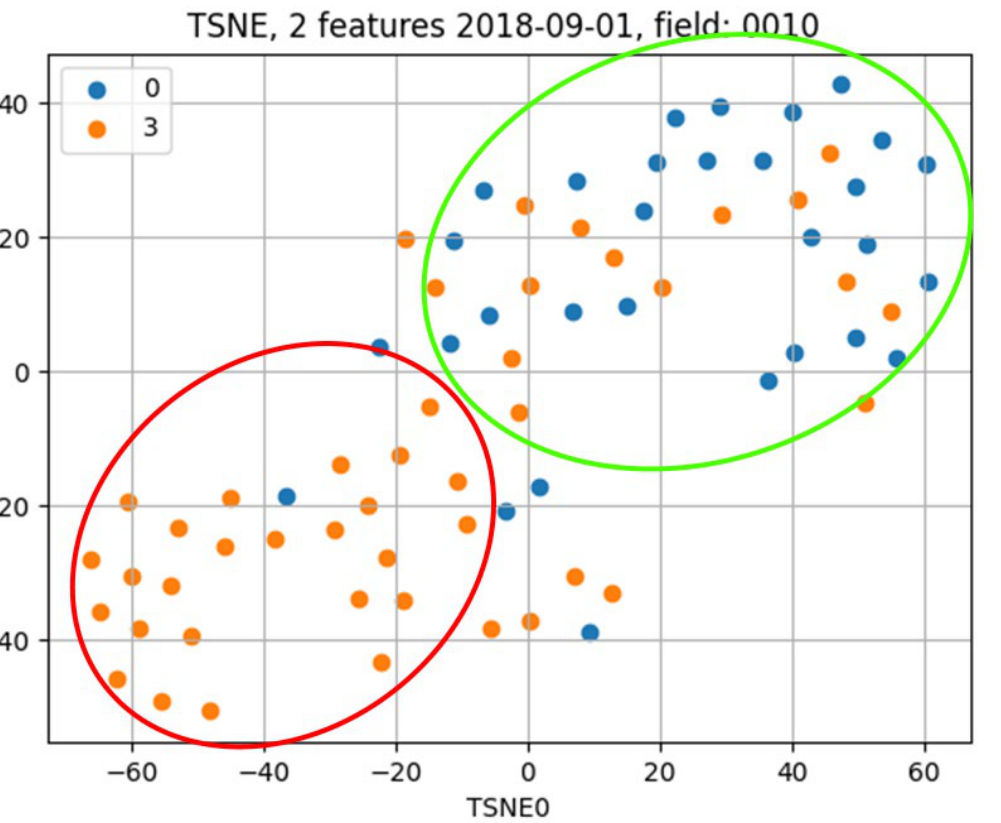
Figure 6. Sample statistical clustering of a series of measurements. Each dot represents one Agroscanner measurement. A 16-dimension index measurement vector was converted to 2-dimensional space using T-Distributed Stochastic Neighbor Embedding algorithm. Red and green spaces represent two different clusters for two different fertilizer groups.